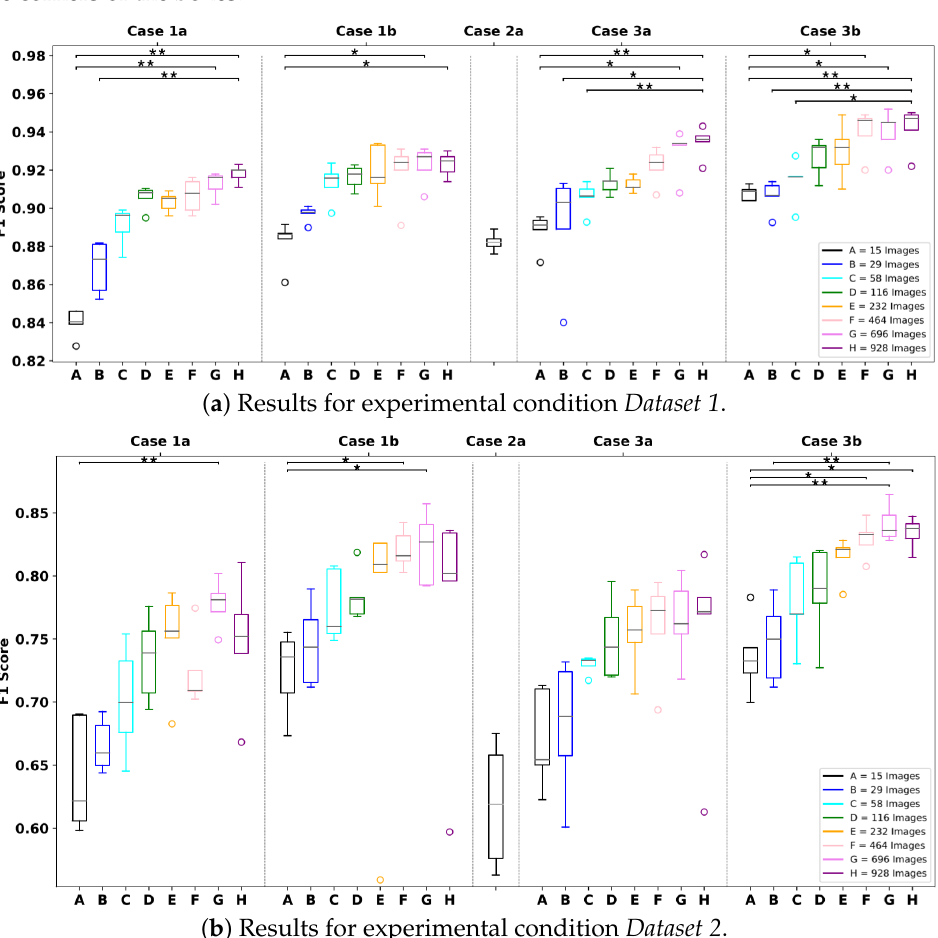
Figure 5. The boxplot of the F1-score distributions on the test sets for the comparison of a fixed scenario varying the training set size, considering Dataset 1 ( a ) and Dataset 2 ( b ). Case 1a, Case 1b, Case 2a, Case 3a, and Case 3b are the scenarios. A, B, C, D, E, F, G, and H are the numbers of the original images used for the training set. * represents statistically significant comparisons with p ≤ 0.05; ** represents p ≤